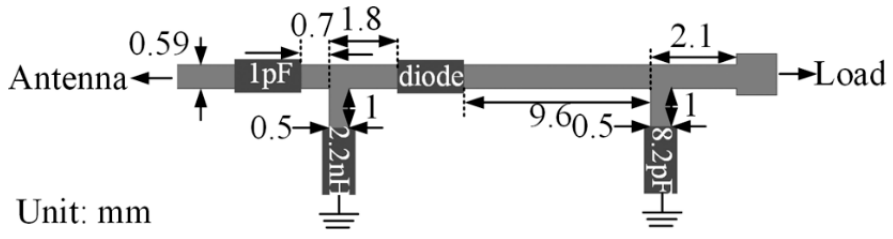
Figure 36. Rectifier schematic for RFF [169]. Copyright © 2014, IEEE.